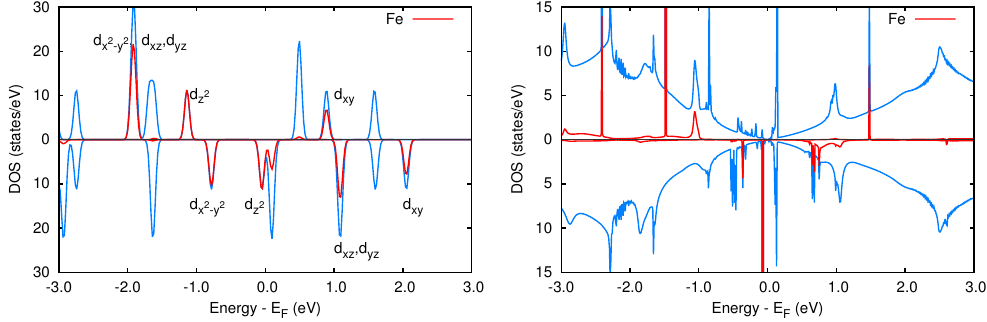
Figure 2. Left panel: Spin-resolved energy levels of the isolated FeP molecule. The red lines represent the contribution of Fe to the molecular orbitals of the porphyrin. Right panel: Spin-resolved total density of states (DOS) of the FeP junction (blue line), along with its projection on the atomic orbitals of Fe (red line).